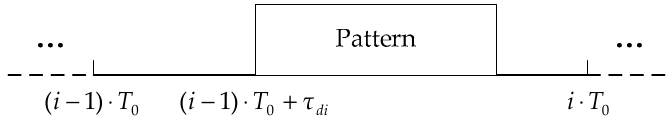
Figure 2. The symbol structure of PDS scheme.